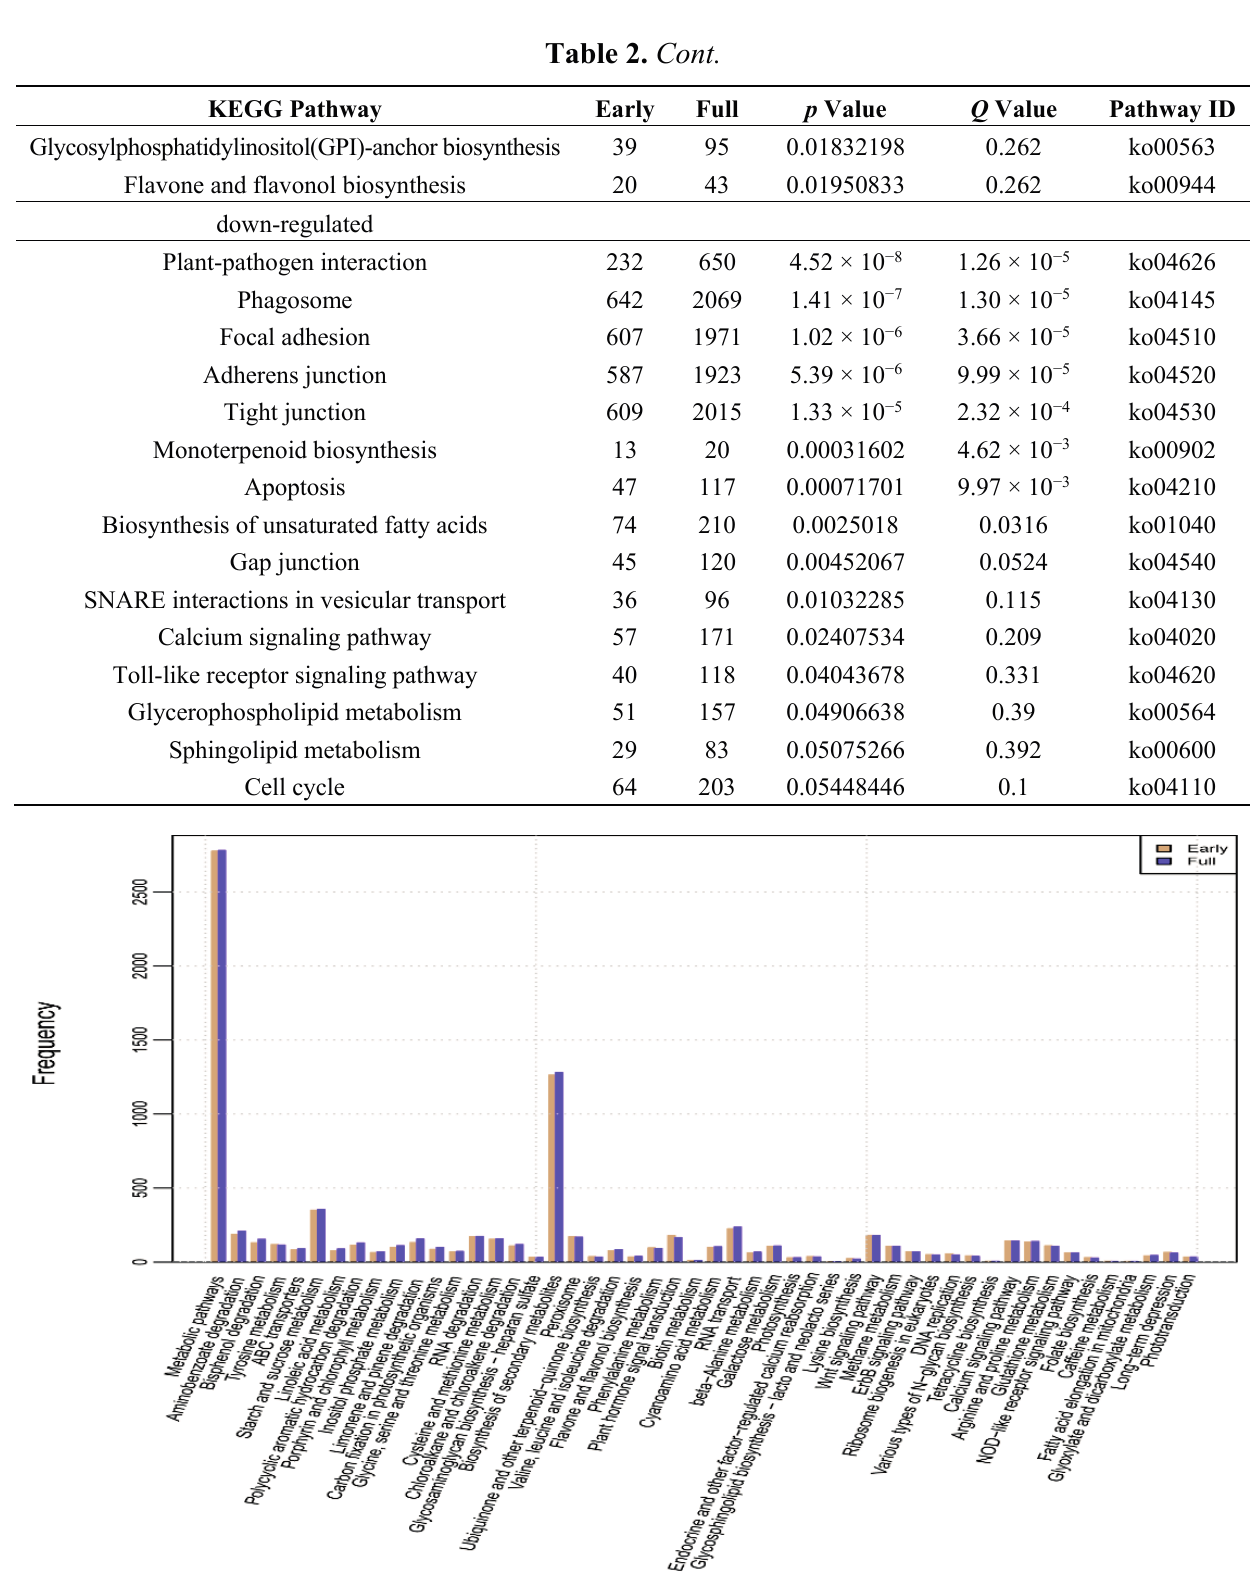
Figure 7. Kyoto Encyclopedia of Genes and Genomes (KEGG) pathways mapped in the safflower transcriptome. The 51,591 unigenes are annotated to 281 KEGG